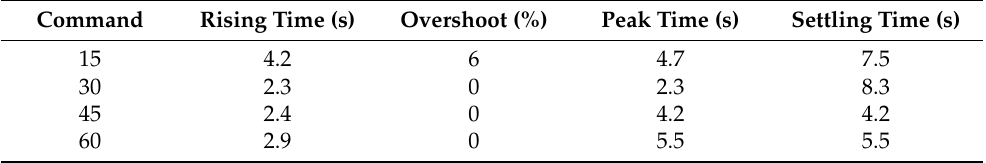
Table 3. Step response characteristics for the NiTiNOL spring’s displacement.